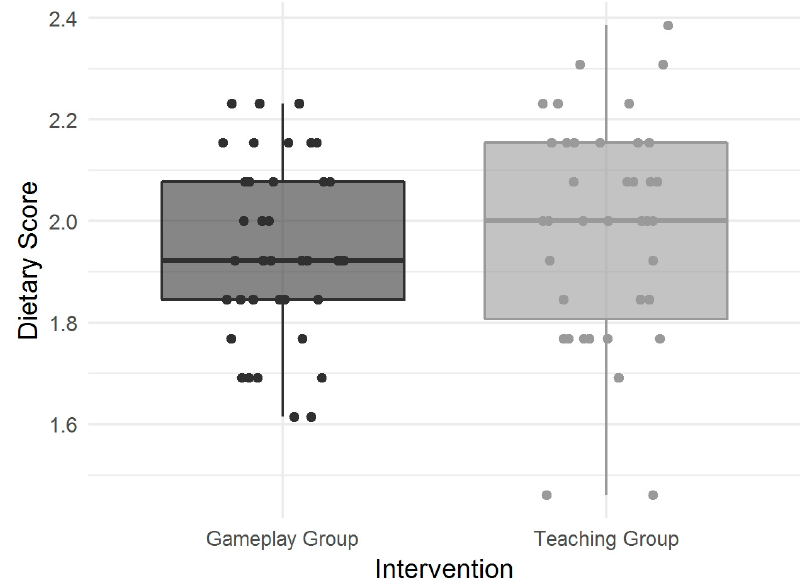
Figure 2. Dietary behavior at baseline depicted as overall dietary score.